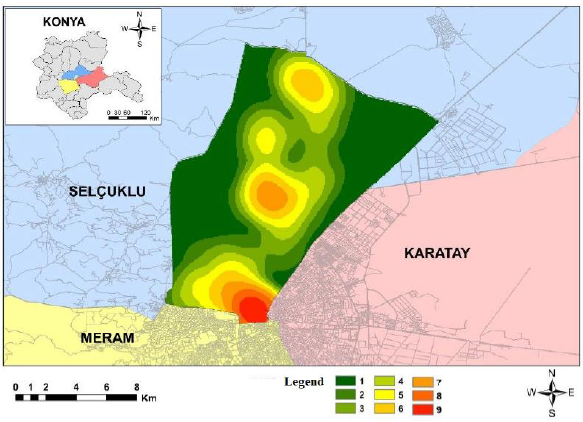
Figure 5. Social and cultural facilities density analysis